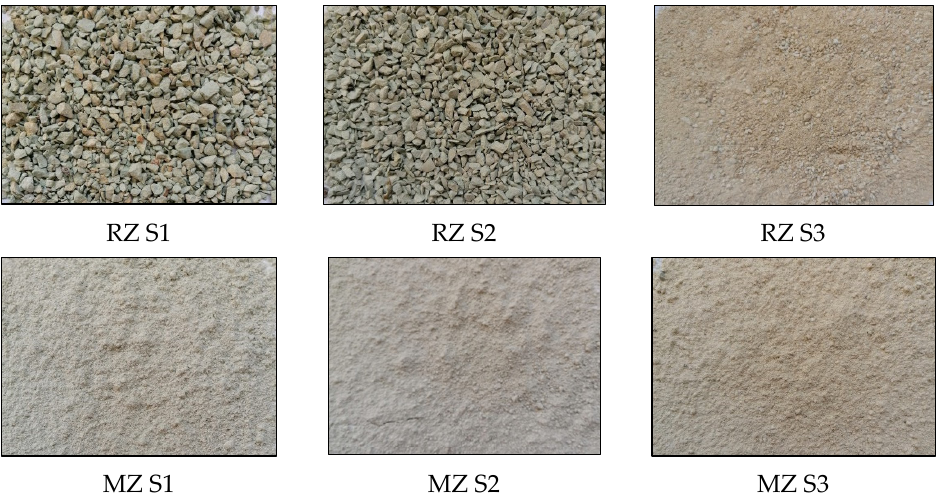
Figure 1. Zeolitic volcanic tuffs before (RZ S1, RZ S2 and RZ S3) and after micronization (MZ S1, MZ S2 and MZ S3).